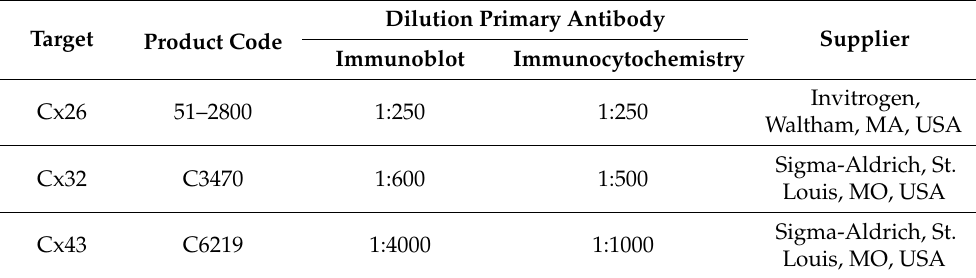
Table 3. Overview of primary antibodies. Specifications regarding the primary antibodies used in this study, including target, product code, dilution used in immunoblot analysis and immunostaining analysis and the